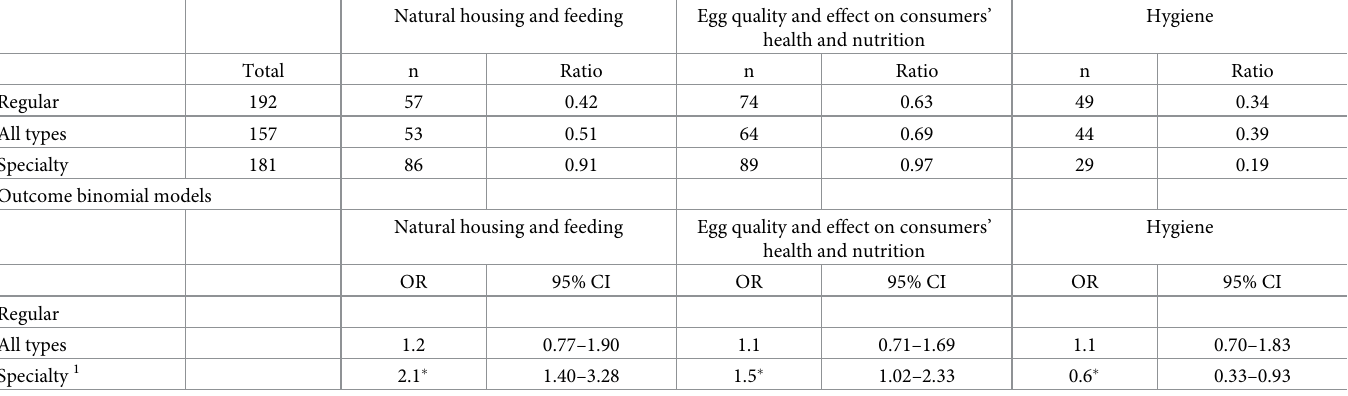
Table 4. The number and the ratio of participants that bought each type of eggs and mentioned each of the emerging themes (natural housing and feeding, egg quality and effect on consumers’ health and nutrition, and hygiene). Odds ratio and 95% confidence interval (95% CI) for binomial models of the type of egg partici- pants usually buy and association with emerging themes are presented.